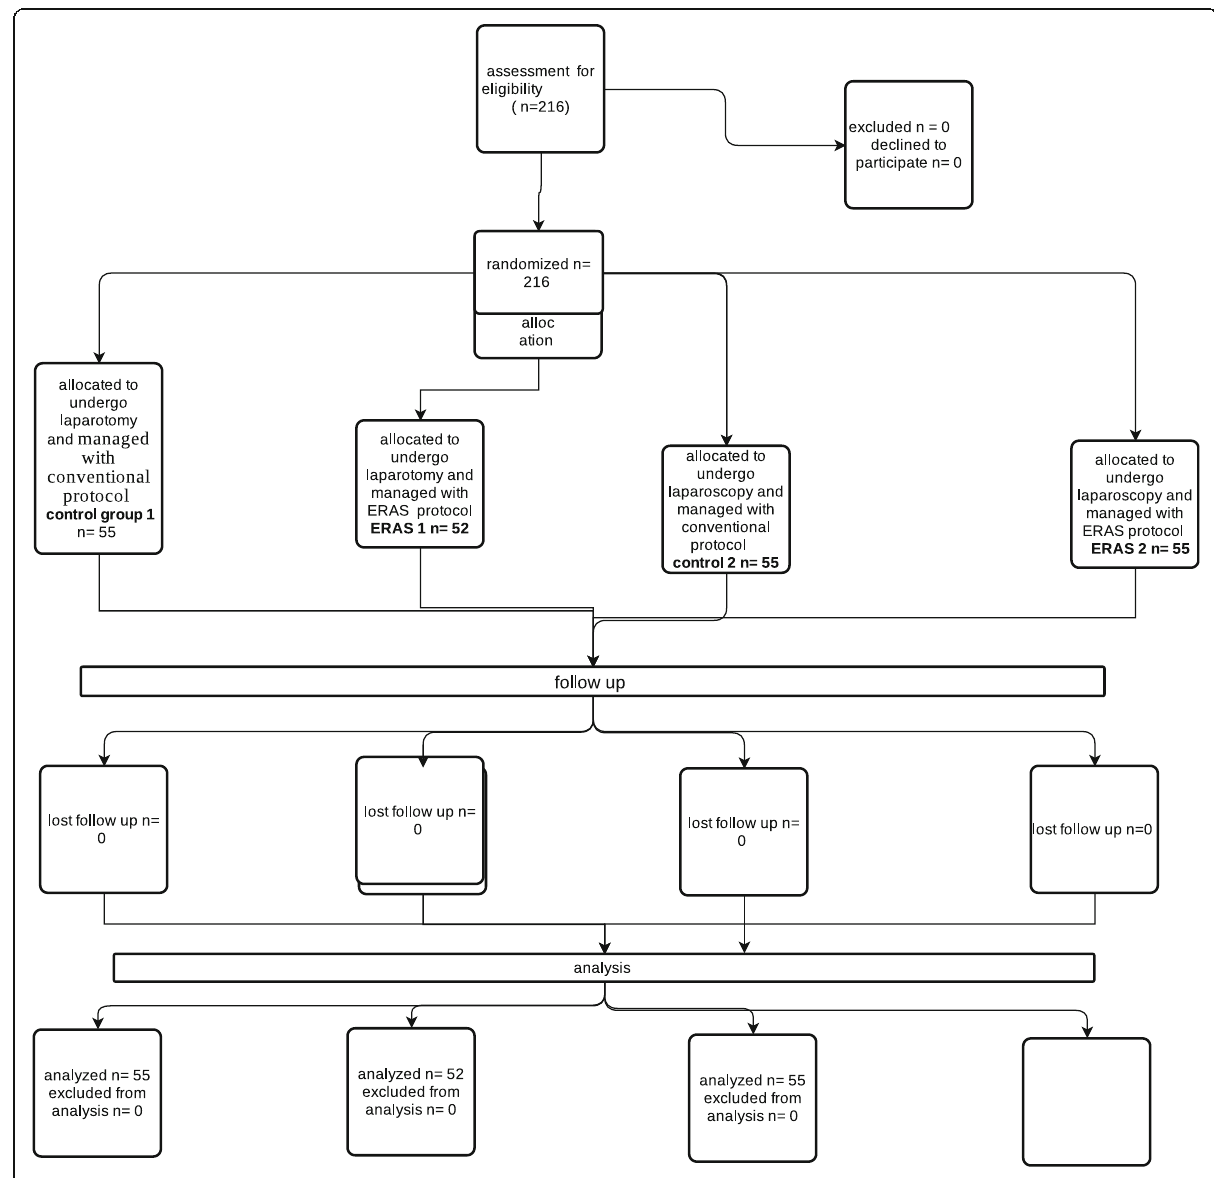
Fig. 1 CONSORT flow diagram showing number of patients at each phase of the